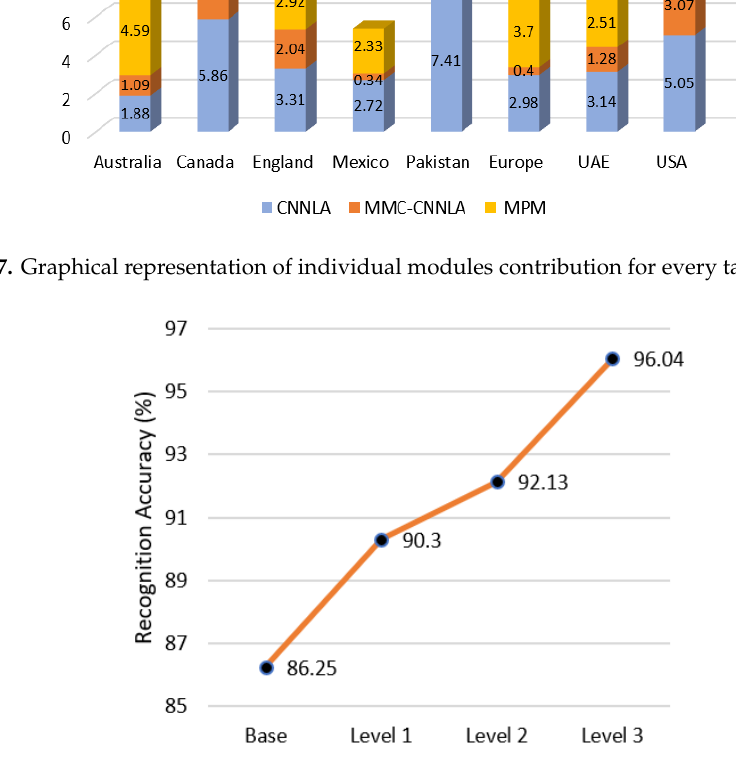
Figure 18. Graphical behavior of accumulative rise in recognition accuracy for proposed modules. Table 6. Comparison with existing methods.